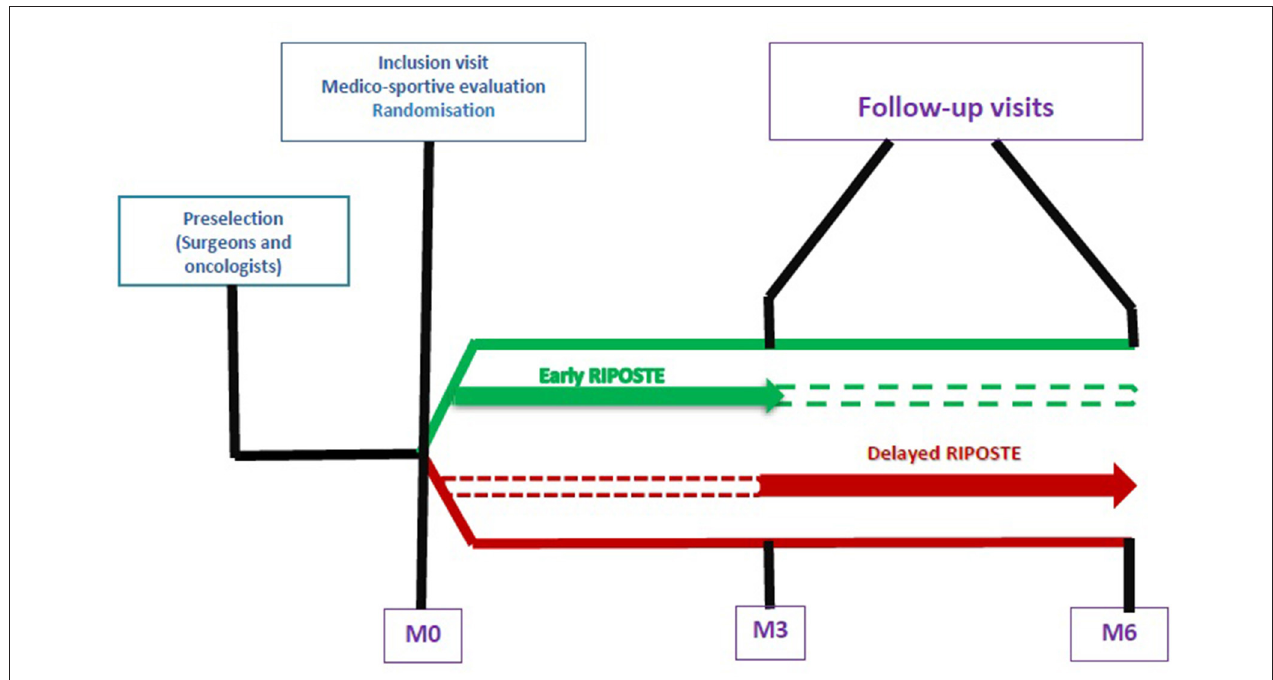
FIGURE 1 | Design of the ≪ Solution RIPOSTE ≫